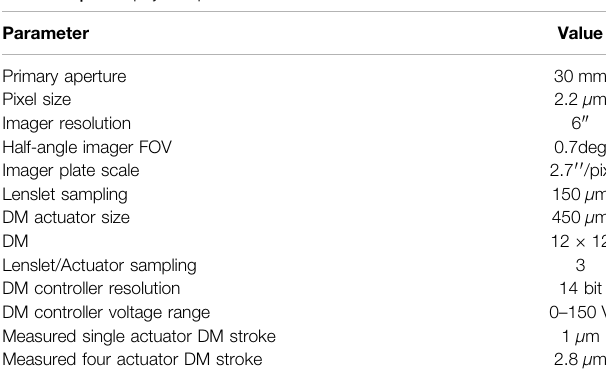
TABLE 2 | DeMi payload